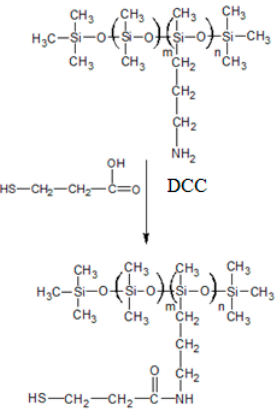
Figure 1. Scheme for thiolation of poly[dimethylsiloxane-co-(3-aminopropyl)-methylsiloxane] in one step synthesis. 3-mercaptopropionic acid was used as thiol ligand and DCC as coupling reagent. A 1 mmol (1eq) solution of the silicone oil, 2 eq of pyridine and 2 eq DCC at 40 cm 3 DCM were cooled to the temperature of 0 ◦ C. The droplets of 2 eq MPA dissolved in 2 cm 3 DMSO were added. Then, the mixture was blended for 1 h at 0 ◦ C. Stirring was continued at room temperature for another 24 h. After this time, purification by filtration of product (thiomer) and a second step of washing with demineralized water were conducted. Proce- dure was finished when pH of the aqueous phase reached neutral value. The remaining excess of the solvent was evaporated on the evaporator. The thiolated silicone oil was centrifuged twice. The obtained silicone-MPA was kept at 4 ◦ C until further